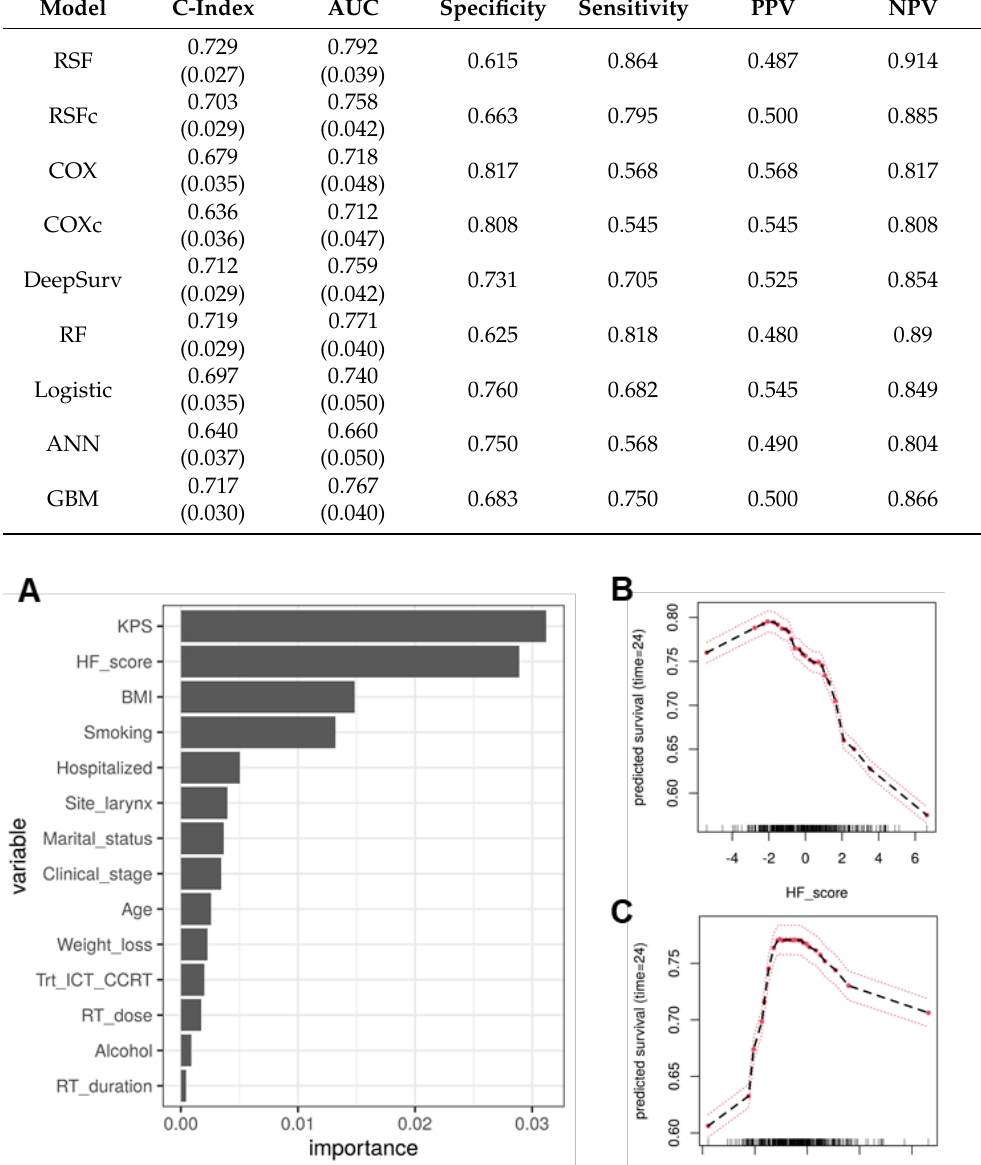
Table 4. Model test performance measured by C-index and AUC of two-year survival. The cutoffs were selected by maximizing the Youden index. For classification models, the C-index is obtained based on the predicted two-year survival probability.